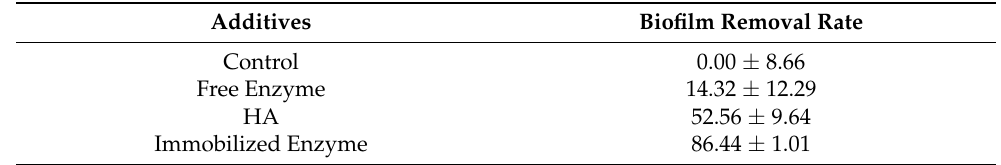
Table 1. The removal rate of different additives on the dental plaque biofilm.